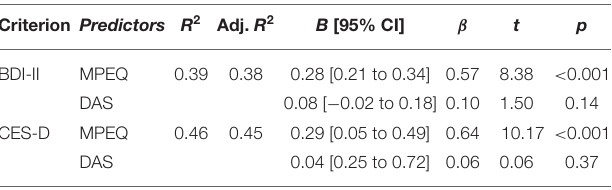
BDI-II, Beck Depression Inventory; MPEQ, Meta Questionnaire Problem Questionnaire; DAS, Dysfunctional Attitude Scale-24; CES-D, Center for Epidemiologic Studies Depression Scale.